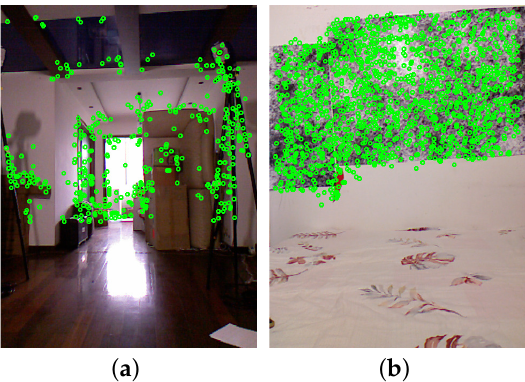
Figure 3. The images depicted in ( a , b ) show the detected keypoints of the image captured in a natural scene, and the image captured in a scene with descriptor-based patterns respectively. Keypoints are represented by green dots.